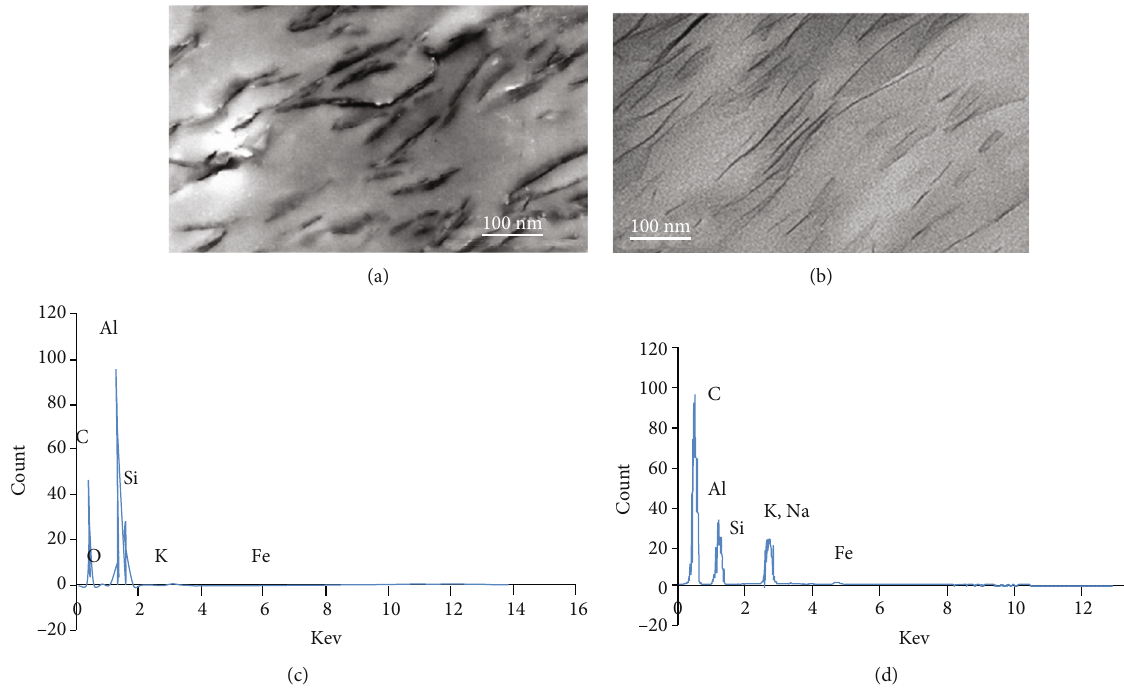
Figure 3: HR-TEM ((a) and (B)) and EDX ((c) and (d)) of WPE/kaolin and WPE/PAMK-TFN